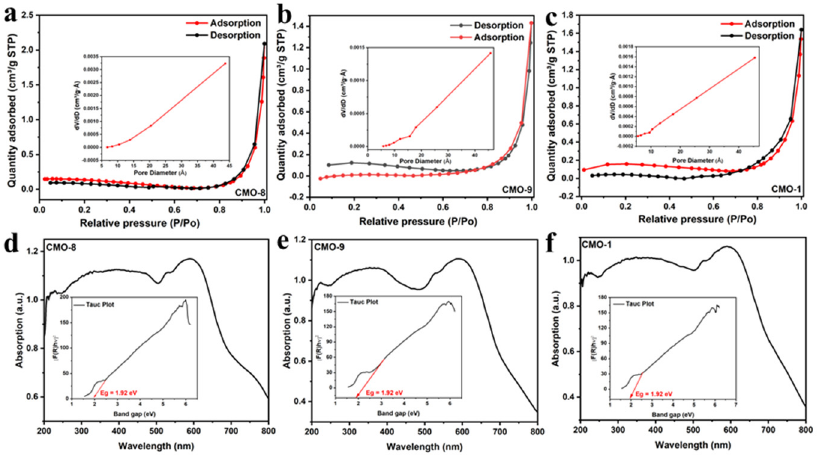
Figure 7. BET of ( a ) CMO-8; ( b ) CMO-9; ( c ) CMO-1; UV-visible diffuse reflectance spectra of ( d ) CMO-8; ( e ) CMO-9; ( f ) CMO-1.